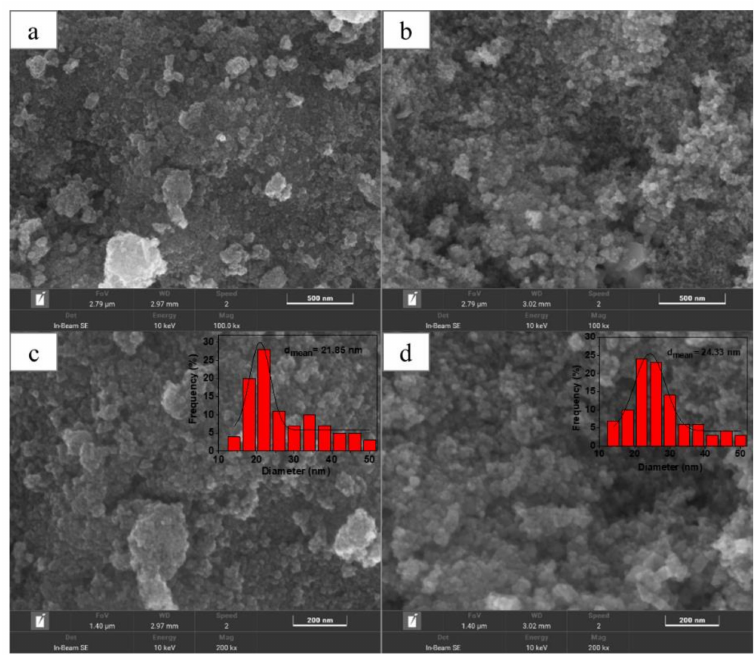
Figure 3. SEM images of Fe 3 O 4 ( a , c ) and MCIL–PEI–Cu ( b , d